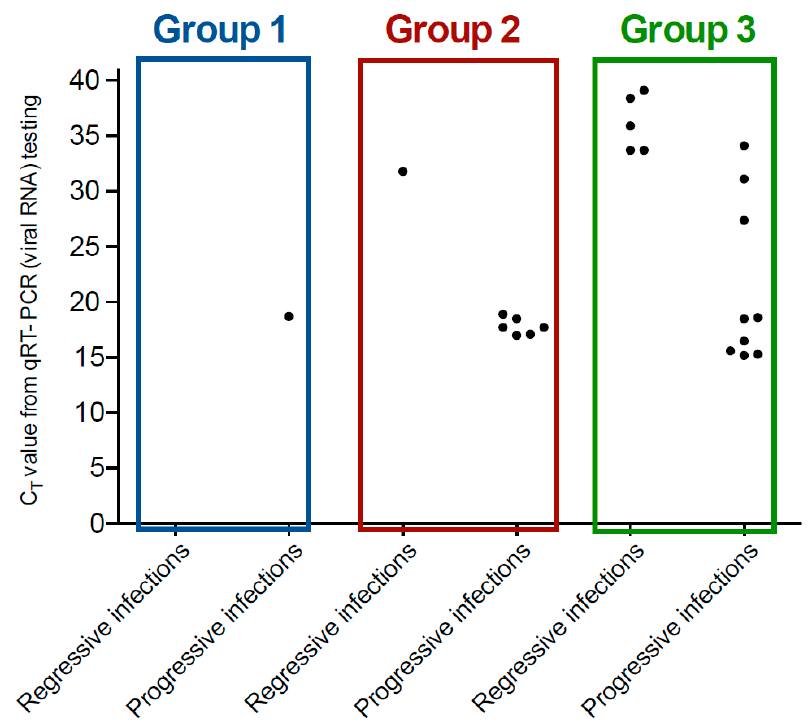
Figure 3. Scatter plot of C T values ( y -axis) from FeLV qRT-PCR testing of EDTA-anticoagulated plasma samples for the three groups of cats by type of FeLV infection ( x -axis). Samples with a C T value of less than 40 were recorded as a positive result. Presumptively progressively FeLV-infected cats ( n = 18) were significantly more likely to test vRNA-positive than presumptively regressively FeLV-infected cats ( n = 28; p < 0.001), and when presumptively progressively-infected cats tested vRNA-positive they recorded a significantly lower median qRT-PCR C T value than presumptively regressively-infected cats ( p < 0.001). Samples from FeLV-infected cats that tested vRNA-negative are not shown (22 presumptively regressively-infected cats and 2 presumptively progressively-infected cats; refer to Table 4 for more details).